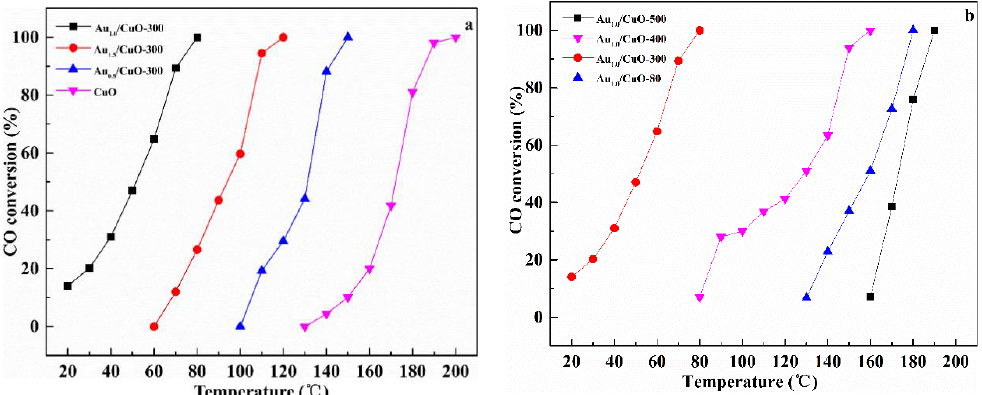
Figure 8. Catalytic activities of CuO and Au X /CuO-300 with different Au loadings ( a ); Au 1.0 /CuO calcined at different temperatures ( b ).